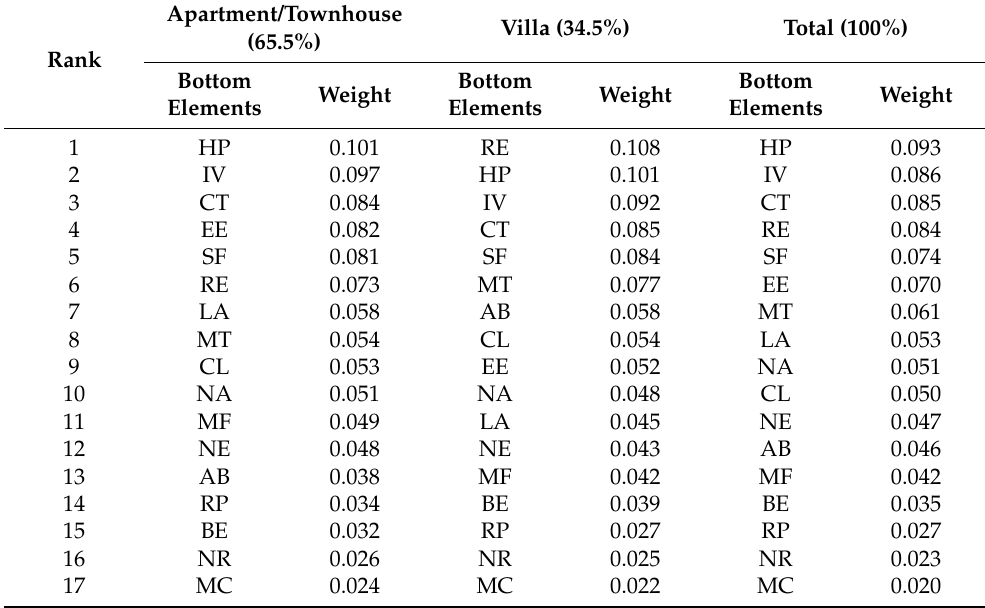
Table 11. The AHP Analysis of Housing Type